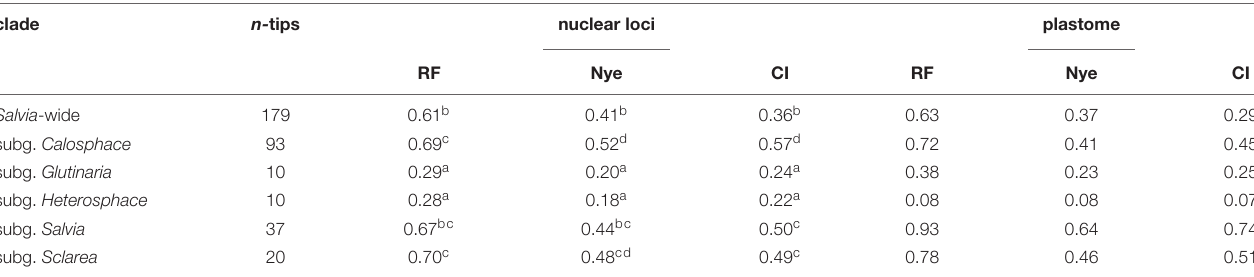
The three different distance metrics, Robinson–Foulds (RF), Nye, and clustering information (CI), compare the topology of the gene trees to the ASTRAL species tree, and we considered the branching order alone. Metrics were calculated on the gene trees that can be rooted and have clade occupancy > 75% of sampled tips. The distances were normalized so that they ranged from 0 to 1, with 0 indicating complete agreement between a gene tree and a species tree. The letters denote significantly different among-group differences for each metric in mean nuclear gene tree discordance compared to the species tree based on an ANOVA with post hoc testing at α = 0.05. Differences among the plastomes were not tested because they represent one gene tree. TABLE 2 | Nuclear gene tree distances in Salvia and selected subgenera. Clade